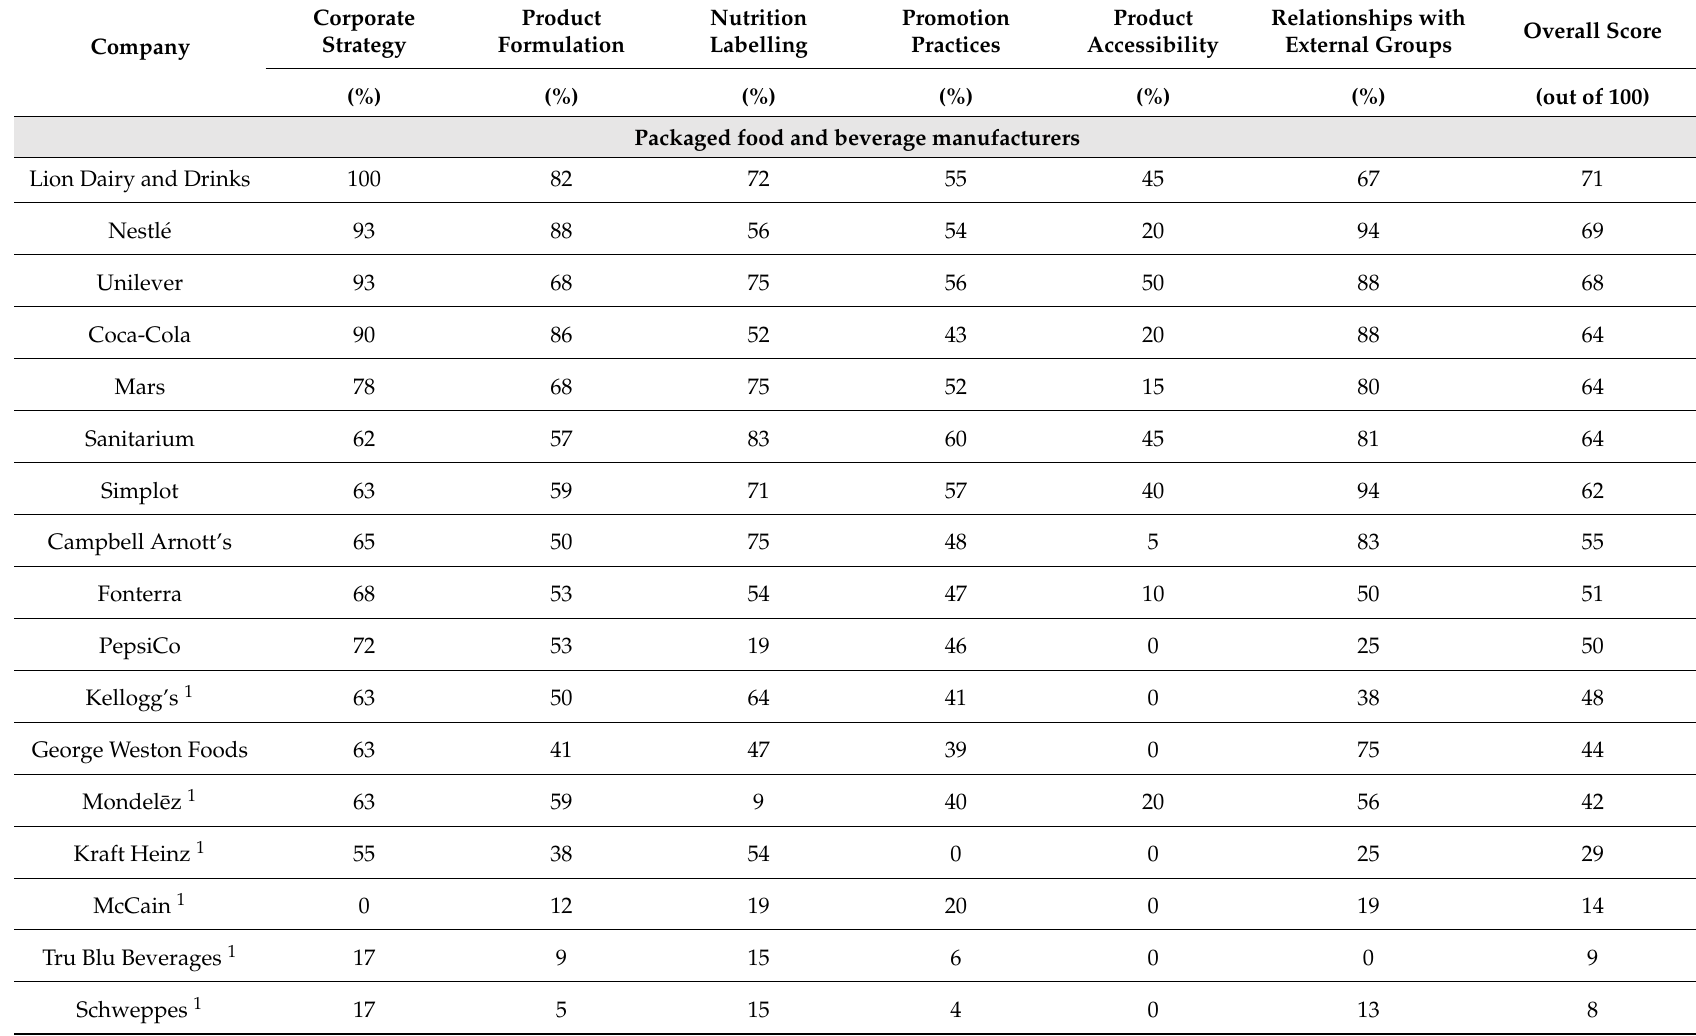
Table 2. BIA-Obesity Australia 2018 , domain-specific company scores by